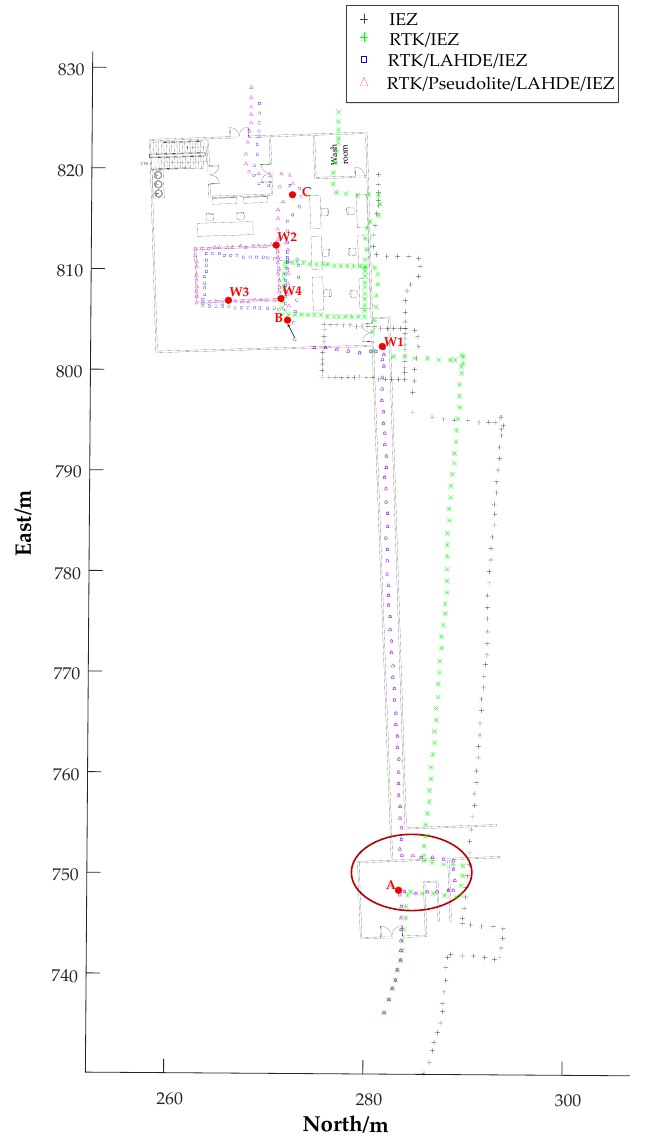
Figure 13 . The trajectories of indoor corridor and indoor room parts of Person A. Figure 13. The trajectories of indoor corridor and indoor room parts of Person